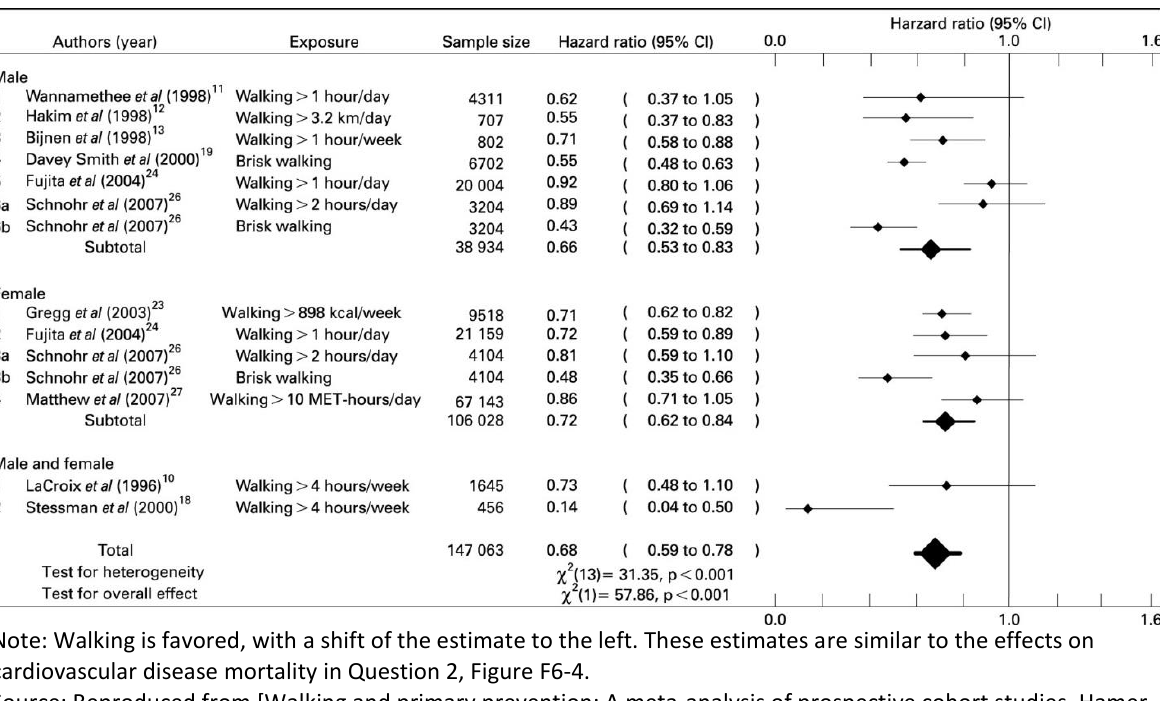
Figure F6-1. The Association Between Walking and All-Cause Mortality in Men and